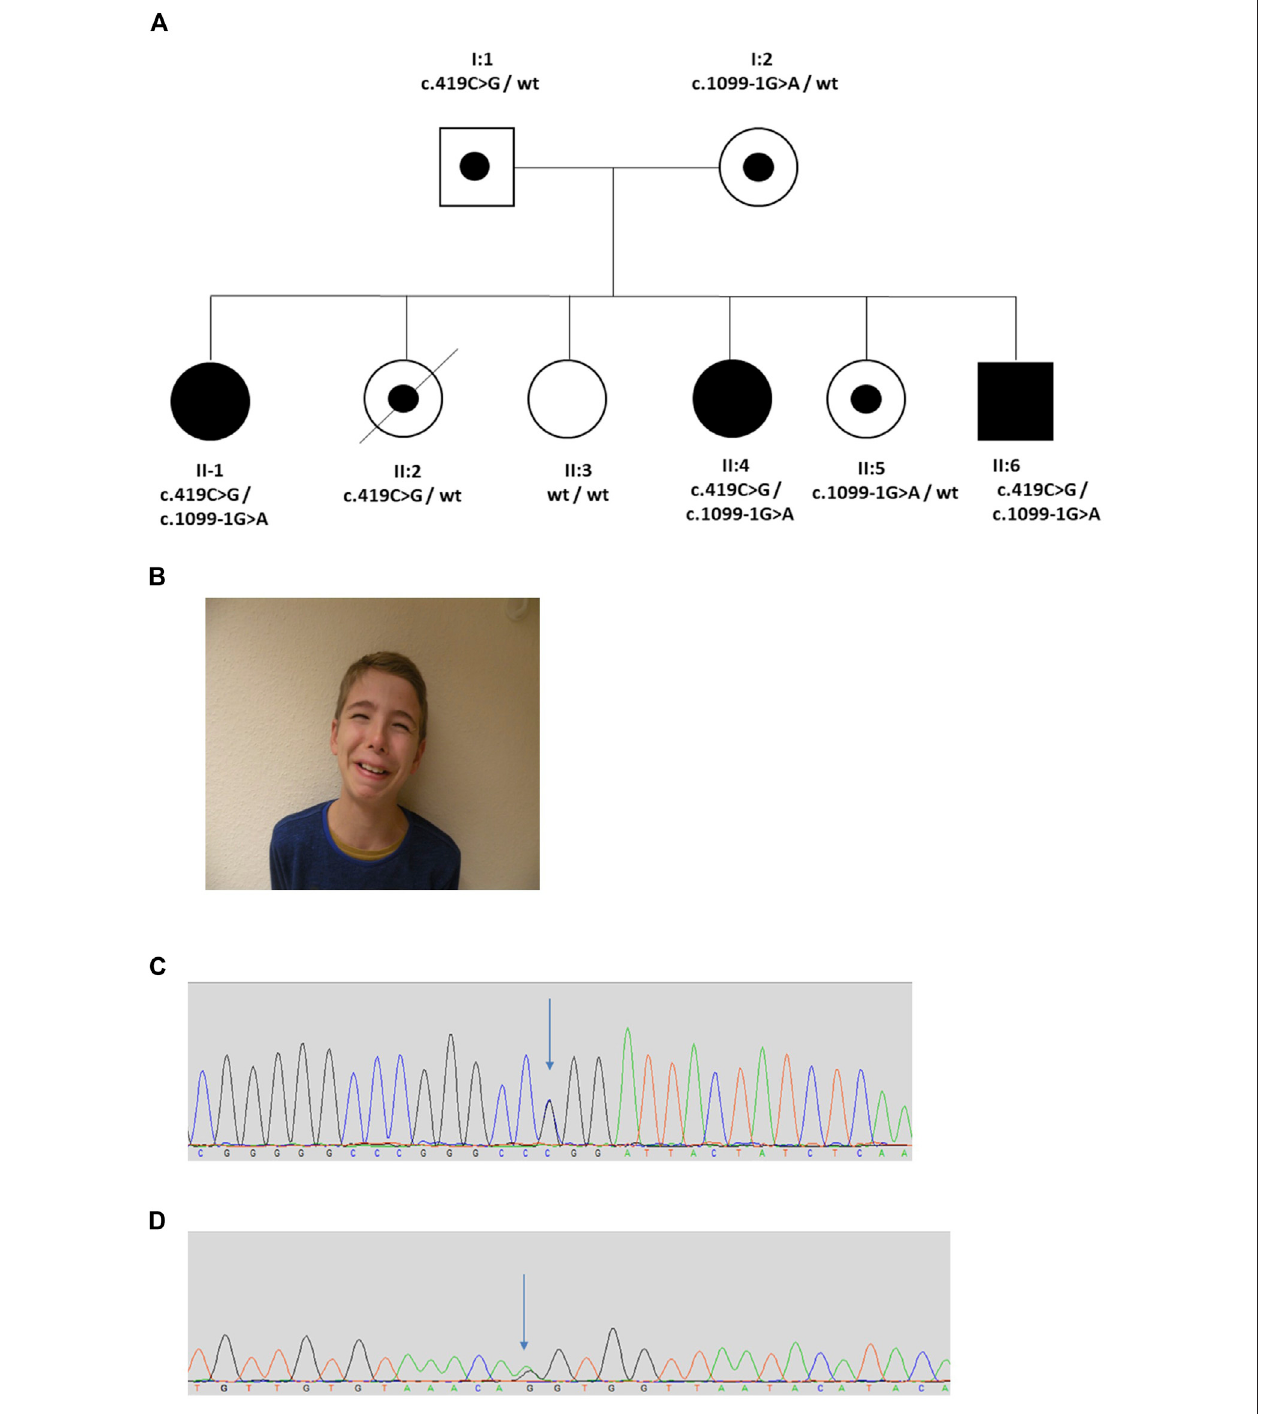
FIGURE 4 | Family 4. (A) . Pedigree of the Family 4 with three individuals affected with UFS (shaded). Dots represent clinically unaffected individuals con fi rmed to carry a HPSE2 heterozygous variant. (B) . Grimace when smiling characteristic of UFS in individual II:6 in the family. (C,D) . Genomic sequence chromatograms showing the HPSE2 heterozygous variants indicated by an arrow (C) c.419C > G, and (D) c.1099-1G > A.